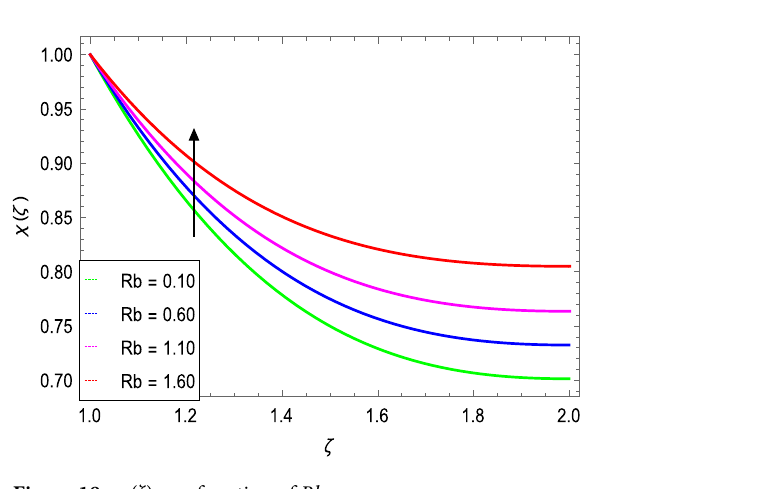
Figure 18. χ (ζ) as a function of Rb